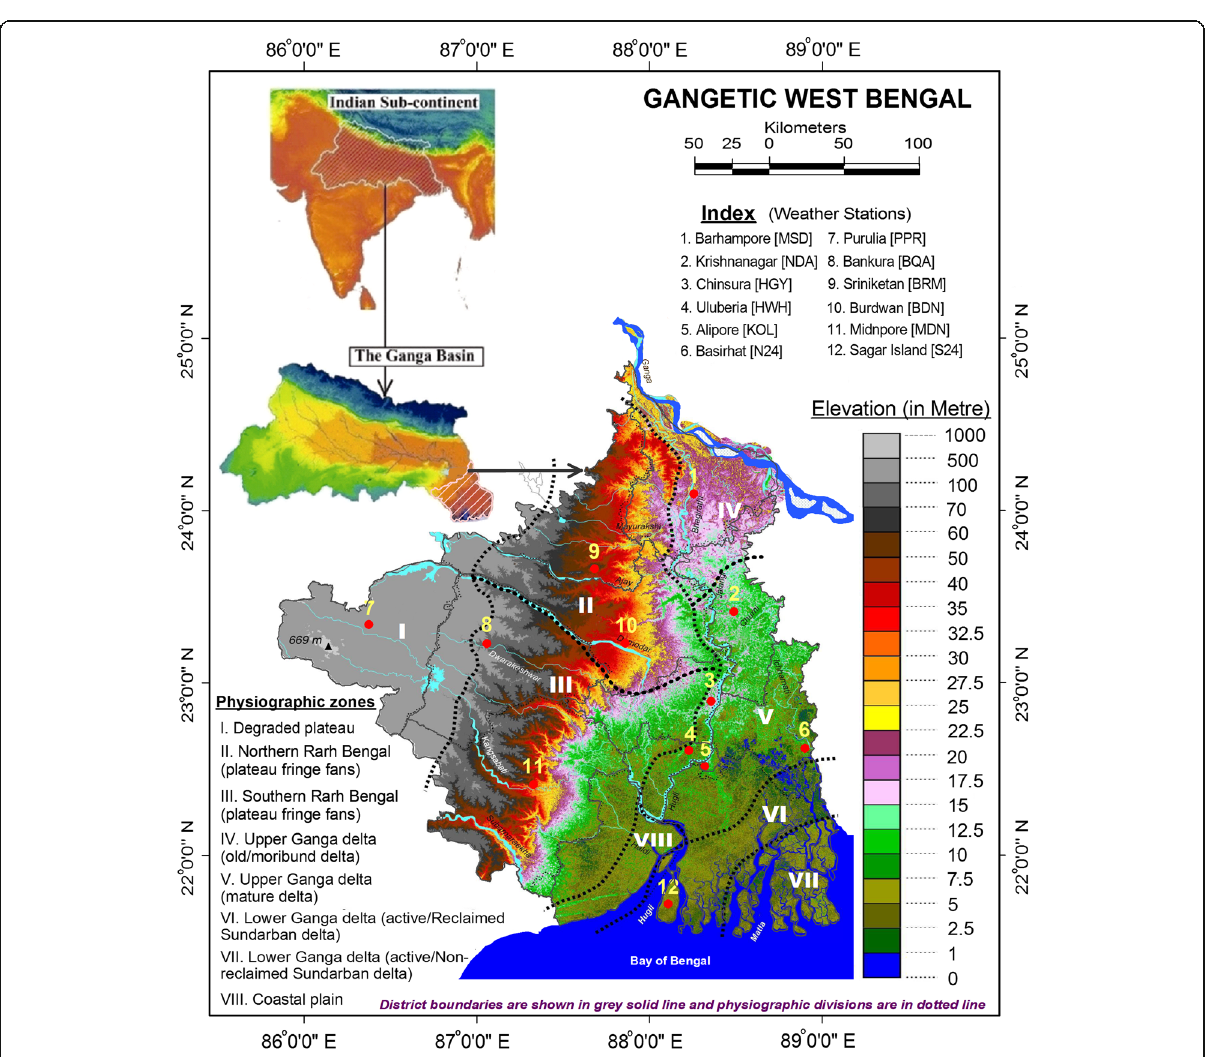
Fig. 1 Reference map of the Gangetic West Bengal showing different height categories, district boundaries, physiographic divisions and location of the representative weather stations used in the analysis. Note: District codes are given in the bracket. Namely, MSD: Murshidabad; NDA: Nadia; HGY: Hooghly; HWH: Howrah; KOL: Kolkata; N24: North 24-Parganas; PPR: Purulia; BQA: Bankura; BRM: Birbhum; BDN: Burdwan; MDN: Midnapore; S24: South 24 Parganas. (Sources: Elevations- SRTM (2000) DEM and SOI Toposheets; Physiographic divisions- Bagchi 1944; Bagchi and Mukherjee 1978, 1983; Islam 2006; Bandyopadhyay et al.